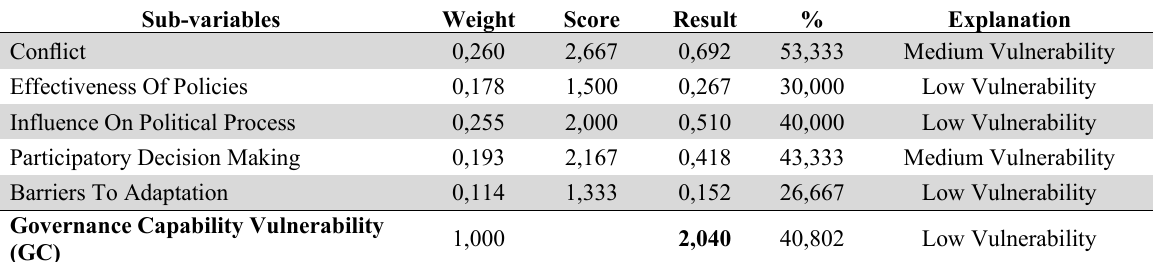
Evaluation of the vulnerability of the TNI-Polri power relations on Adaptive Capacity (AC) vulnerability variable consists of four sub-variables, namely the Technology use accountability (TU) sub-variable with a vulnerability value of 0.203 (23.34%). The Information and Skills (IS) sub-variable has a vulnerability value of 0.365 (30%), The infrastructure (IF) sub-variable has a vulnerability value of 0.486 (40%), The Social Capital and Equity (SC) sub-variable has a vulnerability value of 0.625 (36.67%). Table 16 Vulnerability evaluation scores for power relationship of TNI-Polri in Governance Capability variable.